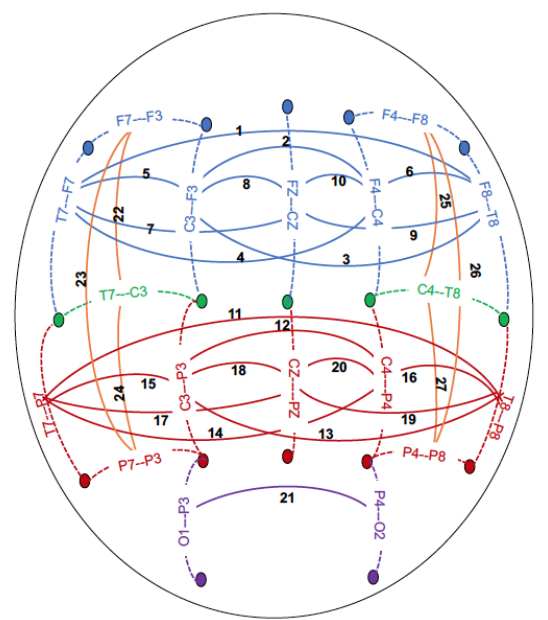
Figure 1. Schematic of the bipolar electrode pairs (connected with dotted lines) and coherence pairs (connected with solid lines) derived between bipolar electrode pairs. Frontal-central sagittal coherence pairs are represented in blue; ( 1 ) F8-T8–F7-T7, ( 2 ) F4-C4–F3-C3, ( 3 ) F3-C3–F8-T8, ( 4 ) F4-C4–